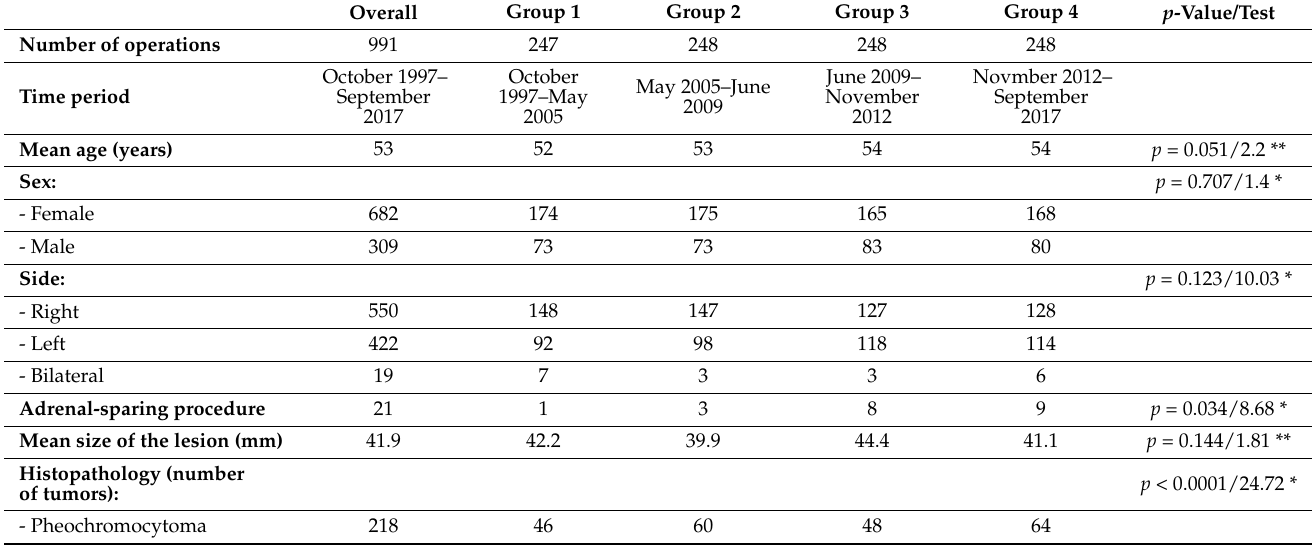
Table 1. Patient and tumor